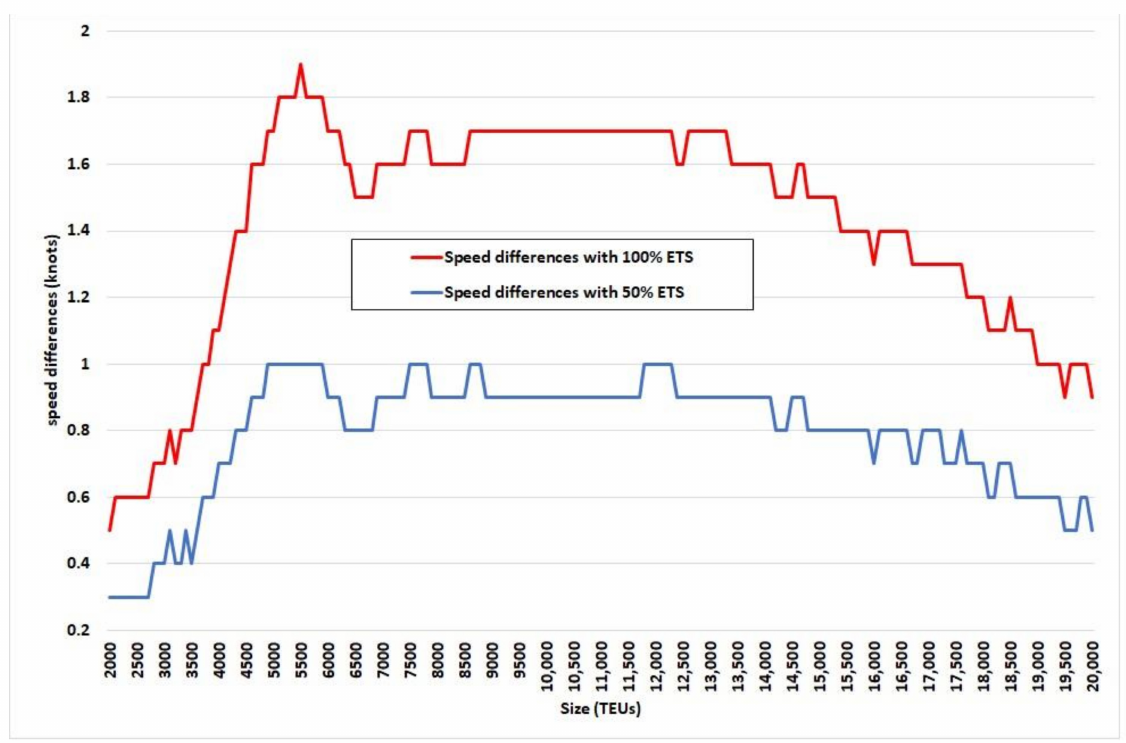
Figure 12. Optimal speed differences between operation with carbon prices (at 100% and 50% Emissions Trading System (ETS)) and without carbon prices as a function of size